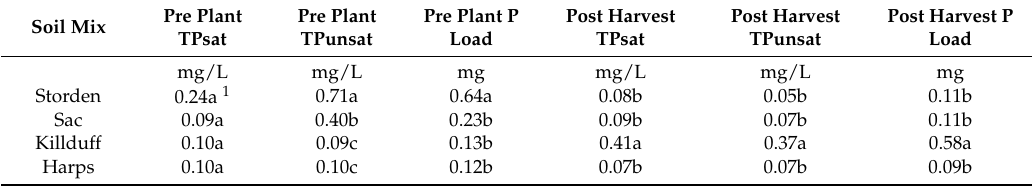
Table 5. Total phosphorus (TP) in saturated and unsaturated effluent of soil mixes (across compost treatments), before planting and after harvest. Also calculated total phosphorus load in preplant and post-harvest effluent, based on outflow volumes for saturated and unsaturated